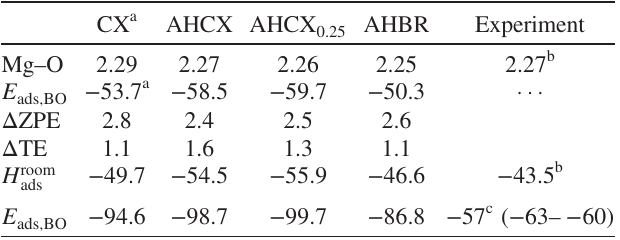
TABLE VI. Comparison of performance for AHBR and for the CX-based tool chain on the CO 2 adsorption energies in Mg- MOF-74, top section, and in m- 2 -m-Zn 2 ð dobpdc Þ , bottom section. All calculations are performed at the CX character- izations for the MOF geometries. For Mg-MOF-74, we permit the CO 2 to relax as described in the stated functional and list the results for the characteristic bond length. We present energy (bond length) results in kJ/mol (in Å) to facilitate an easy comparison with a recent MOF study covering regular vdW- DFs and revPBE þ D 3 [44]. The subscript “ BO ” identifies Born- Oppenheimer results, while the superscript “ room ” identifies adsorption free-energy values that include the effects of vibra- tions as described at room temperature, using Eq. (21) to facilitate a direct comparison to experimental values for Mg-MOF-74. The values in parentheses represent an estimate of how a back